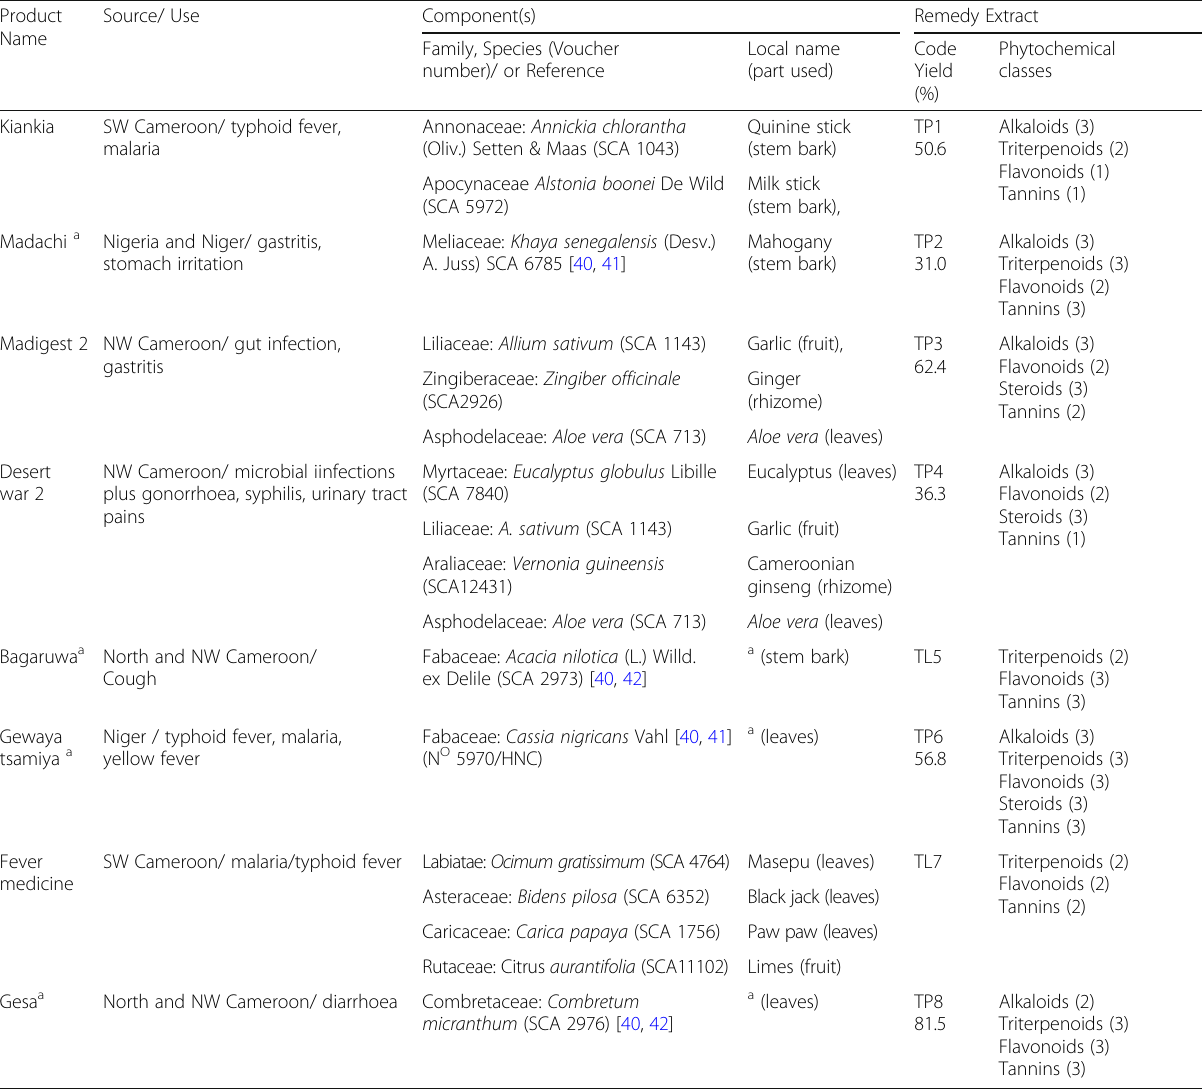
Table 1 Traditional anti-infective remedies purchased in Buea, Cameroon Product